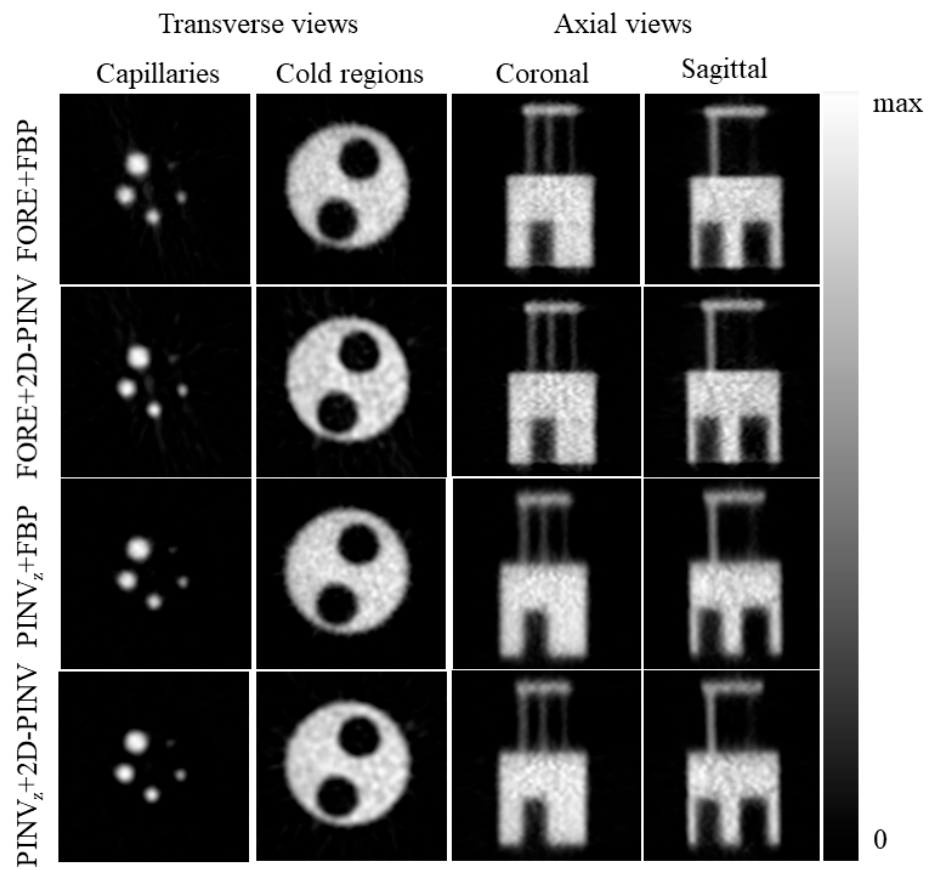
Figure 7. Fourier Rebinning (FORE) and axial Pseudoinverse (PINV z ) rebinned data, coupled with different 2D reconstruction (Filtered Back-Projection (FBP) and 2D Pseudoinverse (2D-PINV)) for the Image Quality National Electrical Manufacturers Association (IQ NEMA) phantom.